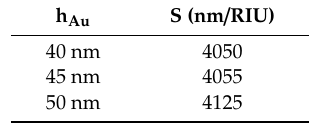
Table 2. Comparison of the refractive index sensitivity of the proposed PCF-SPR with di ff erent h Au from 40 nm to 50